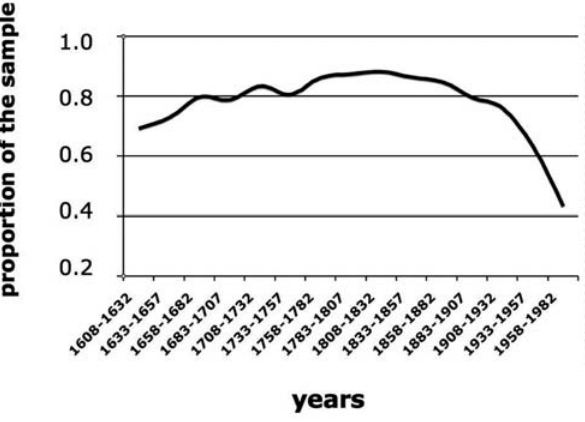
Figure 2. Percentage of endogamic marriages, over the centuries. 25 years periods were considered and are indicated along the X-axis. Marriages were counted from the marriage registers. Endogamy was calculated for the whole valley.